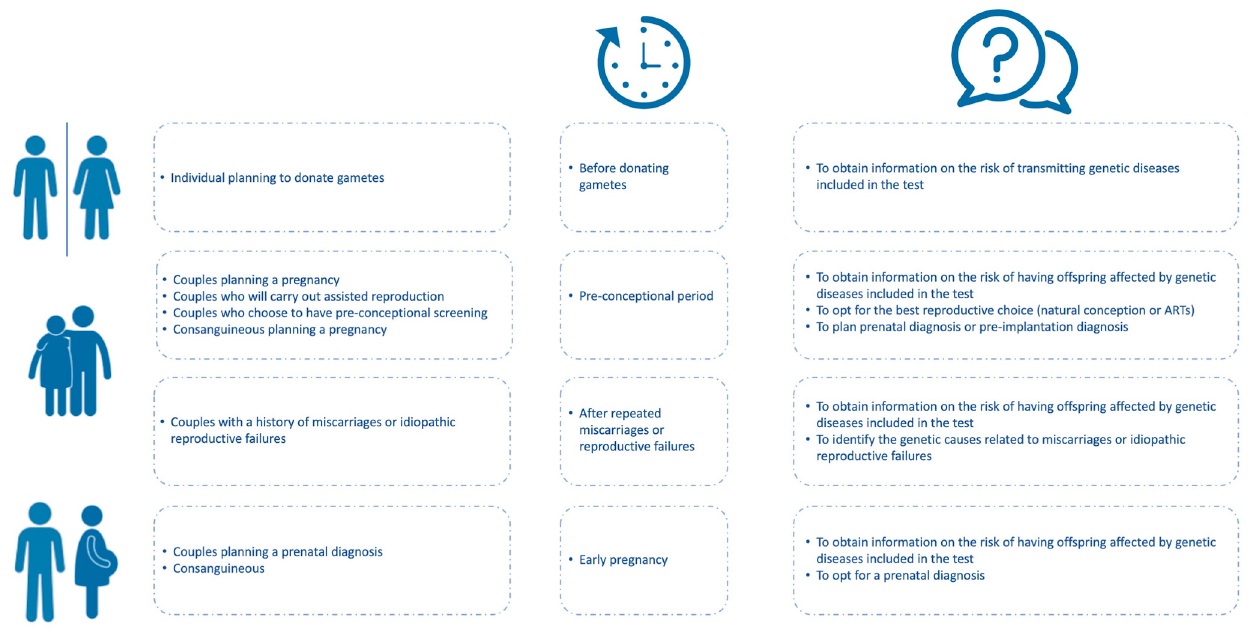
Figure 2. Indications for Expanded Carrier Screening (ECS) planning. ECS has potential benefits in different conditions if properly used. Who is admitted to the test, when it should be preferably carried out, and which kind of information it can provide are summarized herein, underlying its potential advantages in routine diagnostic settings.